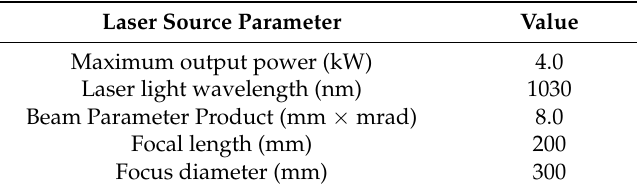
Table 2. Main technical features of the laser